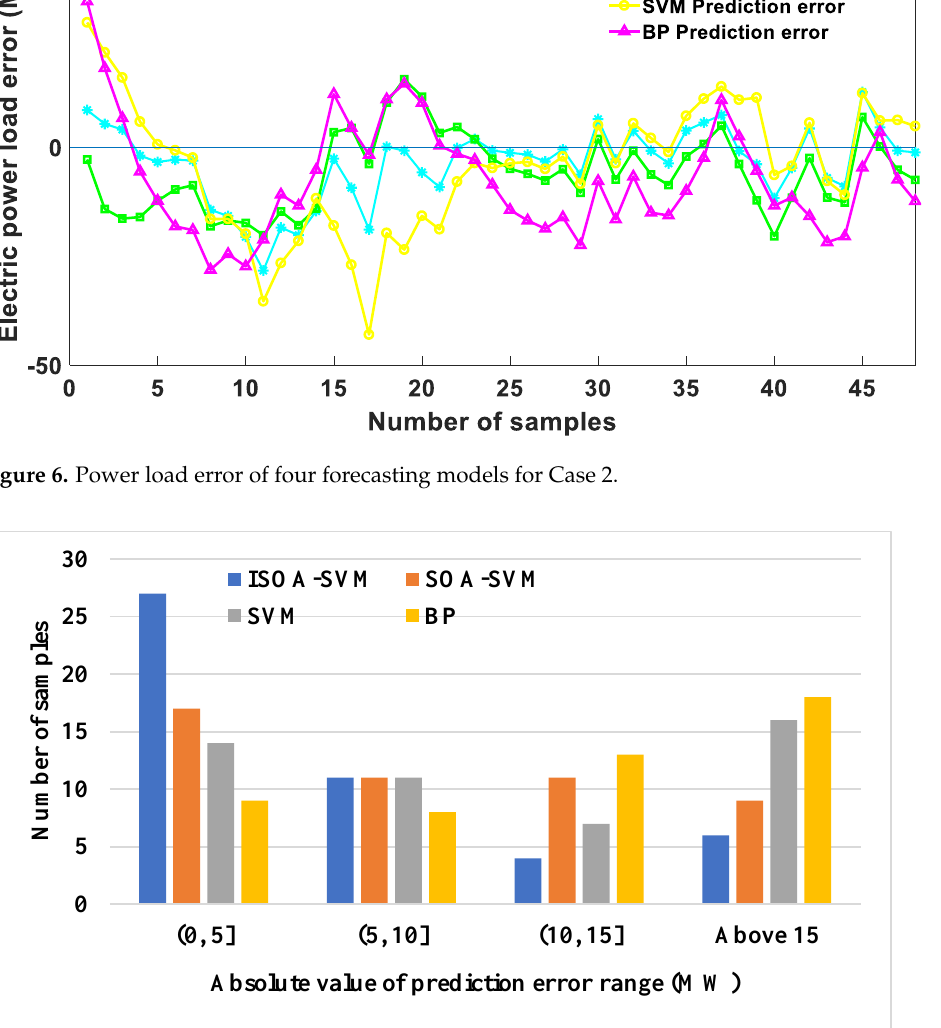
Figure 7. The error histograms of four power load forecasting models for Case 2.